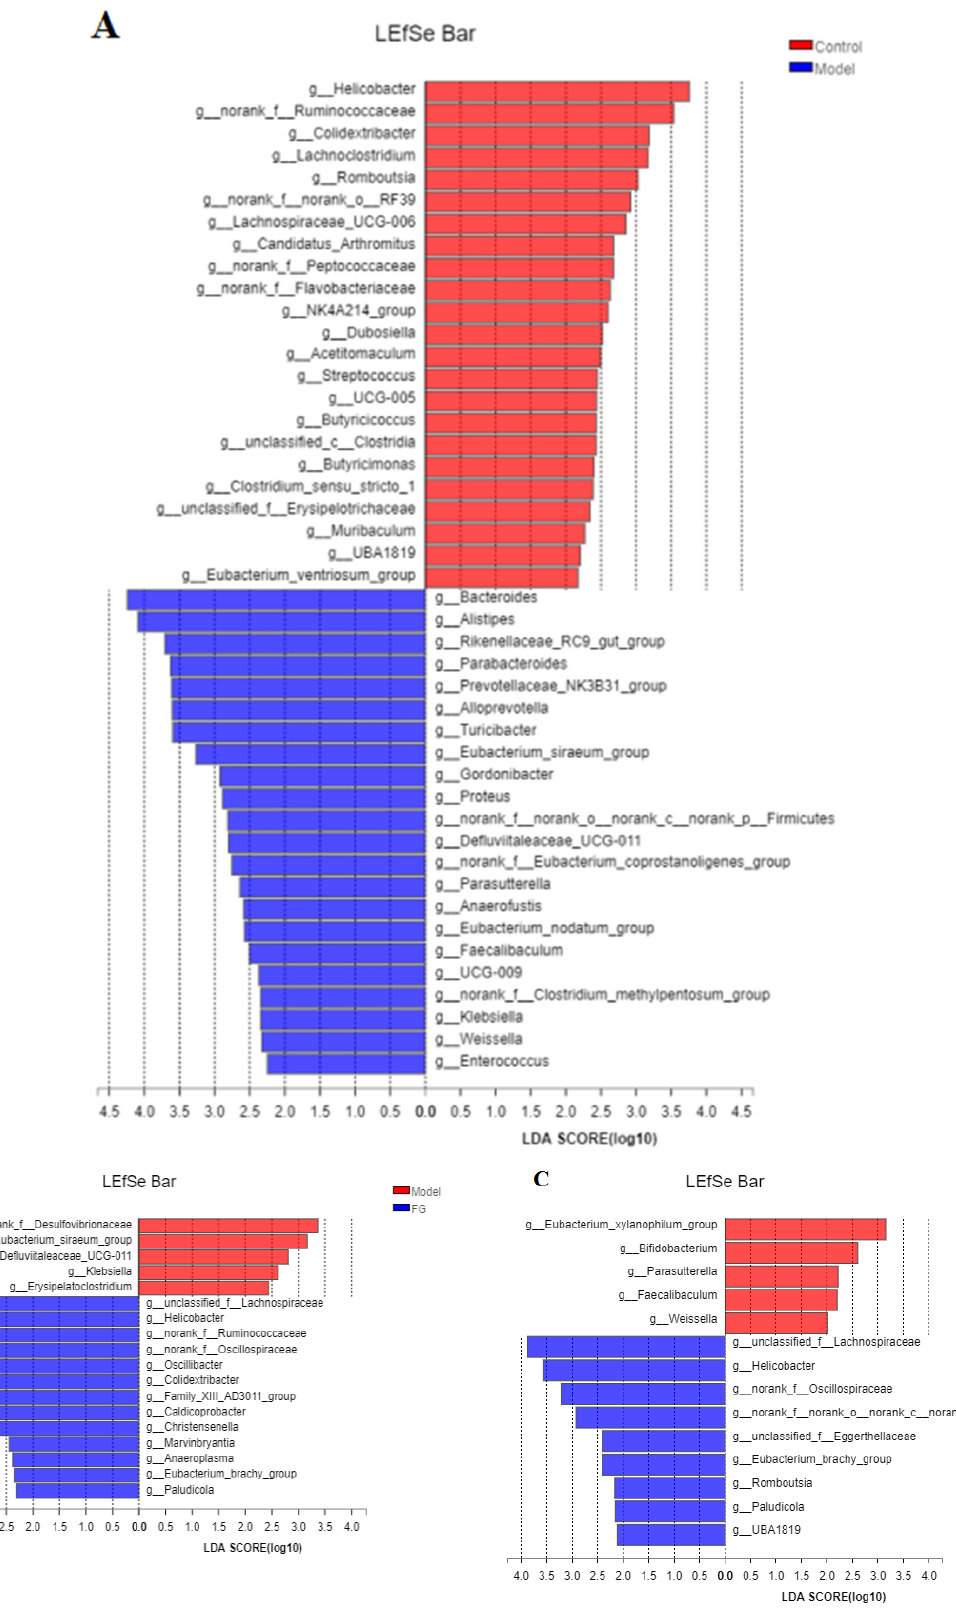
Figure 15. LEfSe linear discriminant analysis of the cecal microflora in db/db mice (( A ). normal group vs. model group; ( B ). model group vs. FG group; ( C ). model group vs. GG group).